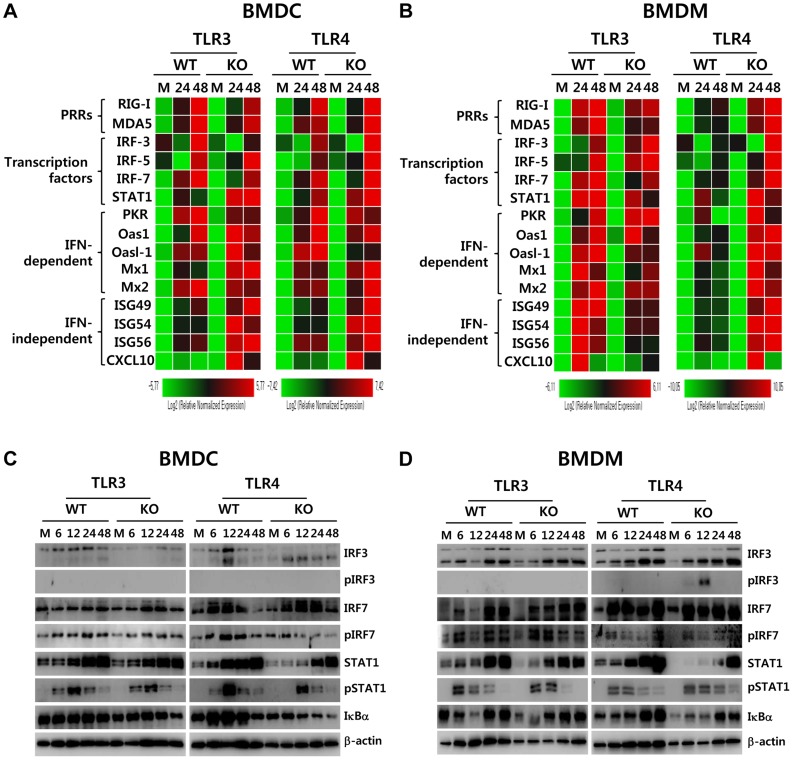
ISG induction, phosphorylation of IRFs, and IκBα degradation in primary myeloid cells derived from TLR3−/− and TLR4−/− mice after JEV infection.
A and B. Clustered heatmap showing the expression of IRF, ISG, and RLR genes in infected BMDC and BMDM. Primary bone marrow-derived DCs (BMDC) and macrophages (BMDM) recovered from TLR3−/− and TLR4−/− mice were infected with JEV at a MOI of 10 or mock-infected (M), and employed to analyze the induction of IRF, ISG, and RLR genes at 24 and 48 h pi. The expression of each IRF, ISG, and RLR gene was normalized to β-actin after determining mRNA levels by real-time qRT-PCR, and displayed as the average of at least four independent samples, according to the indicated color on a log2 scale. C and D. Expression and phosphorylation of IRF3, IRF7, and STAT1 and IκBα degradation. BMDC and BMDM derived from TLR3−/− and TLR4−/− mice were infected with JEV at 10 MOI or mock-infected (M). At 6, 12, 24, and 48 h after infection, cells were lysed, separated by SDS-PAGE and analyzed by western blot to detect unphosphorylated and phosphorylated form of target proteins using specific Abs. One representative picture of at least three experiments is shown.